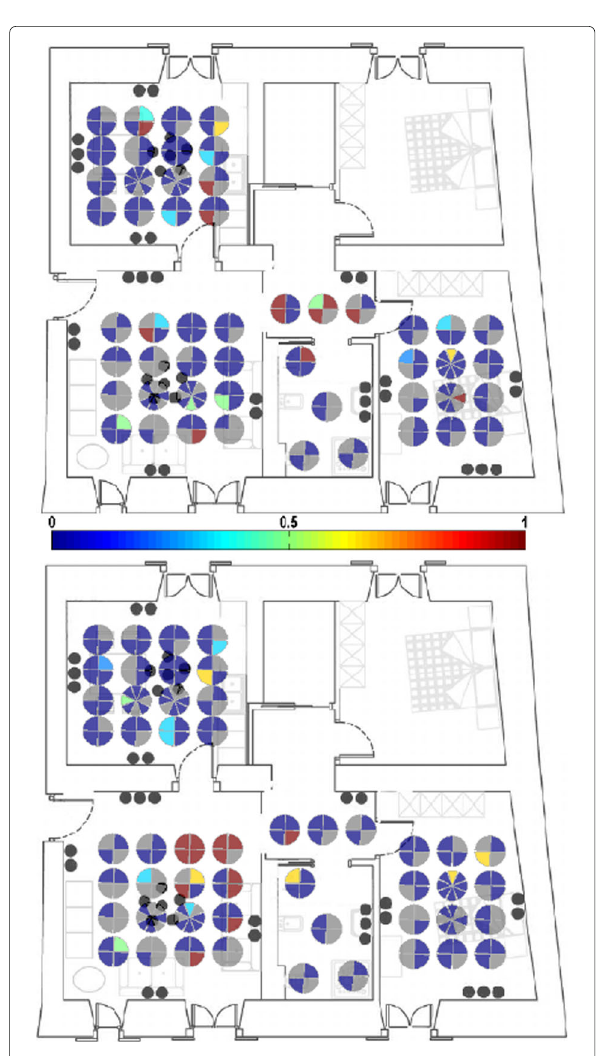
Fig. 10 Visualization of error rates in living room-inside vs. living room-outside segment classification for each speech source position and orientation on the DIRHA-sim test set, using two features of Section 5.1. Upper: spectrogram texture smoothness. Lower: SRP-based feature. Blue and red circular sectors indicate low and high percentage of errors, respectively, while gray sectors indicate unused orientations